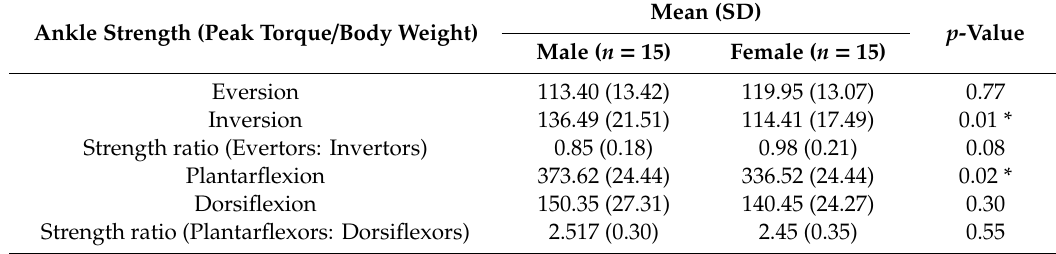
Table 1. Comparison of isokinetic ankle strength across male and female university athletes ( n = 30). Ankle Strength (Peak Torque / Body Weight)